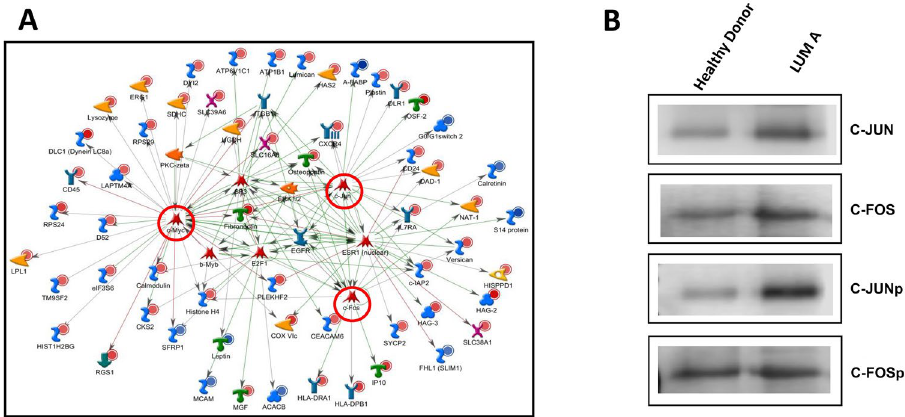
Figure 1. Comparison of the gene expression profiles of luminal A patients and healthy donors indicates that C-JUN and C-FOS are putative candidate regulators of the differentially expressed genes. ( A ) Network based on putative upstream regulators illustrates C-JUN, C-FOS and C-MYC as putative candidates as upstream regulators of the differentially expressed genes in luminal A × healthy donors. Overexpressed genes are marked with red circles; and downregulated genes are marked with blue circles. ( B ) Western blot analysis of C-JUN, C-FOS, C-JUN phosphorylated (C-JUNp) and C-FOS phosphorylated (C-FOSp) antibodies. Thirty micrograms of protein extracts from Healthy Donor and LUM A breast tissues were separated by SDS-PAGE and probed with the previously mentioned specific antibodies. Rouge Ponceau staining was used as the loading